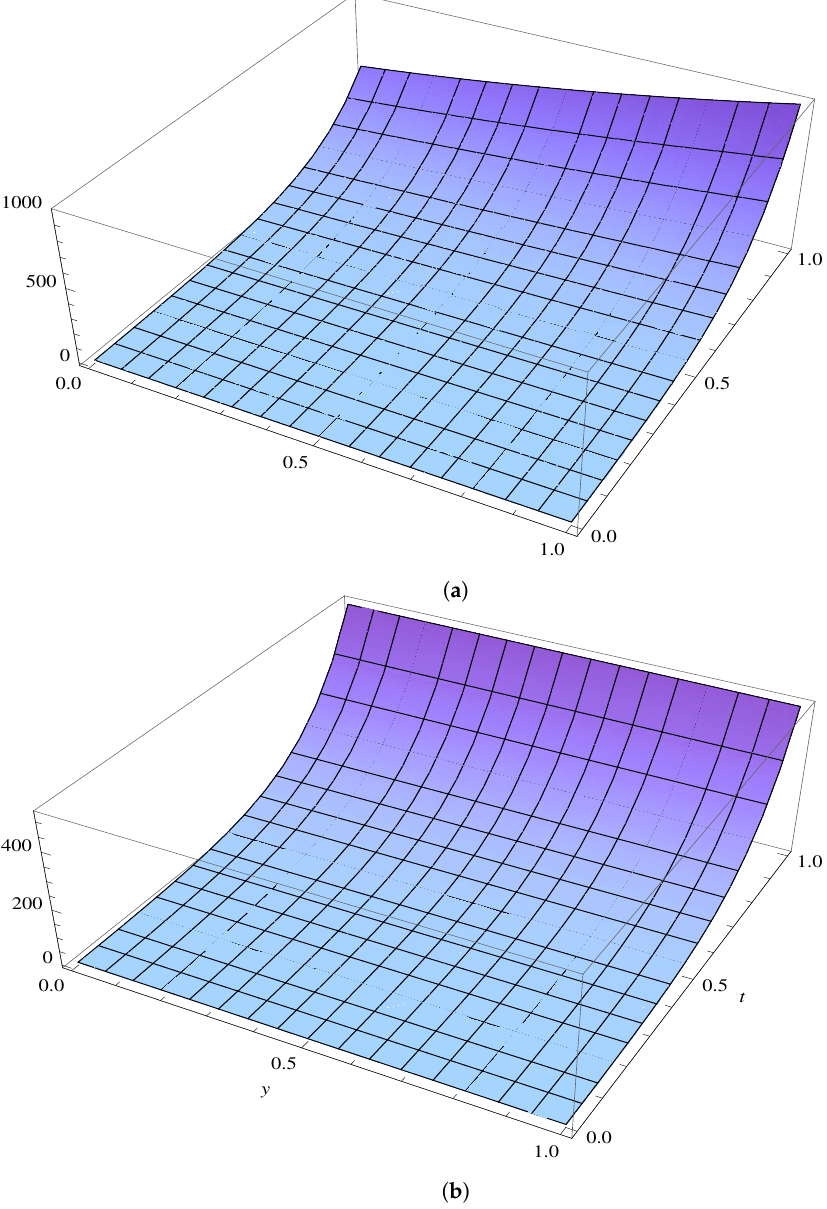
Figure 9. ( a ) (Exact solution: nonfractional) and ( b ) FRDTM β =